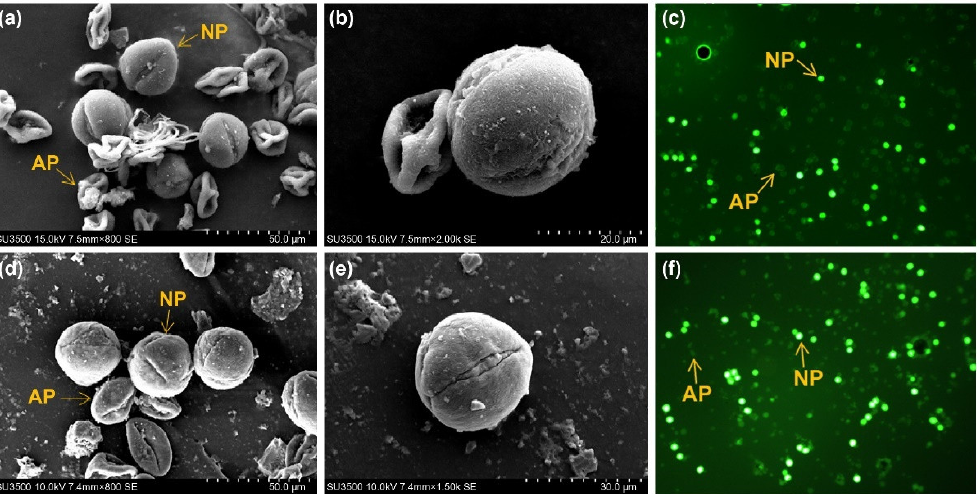
Figure 5. Scanning electron microphotographs of pollen shapes of ‘Mishell’ ( a , b ) and ‘Tineke’ ( d , e ). NP: normal pollen, AP: abnormal pollen. Light microphotographs of FCR test results for pollen germination of ‘Mishell’ ( c ) and ‘Tineke’ ( f ). Table 5. Anther and pollen paternity characteristics.